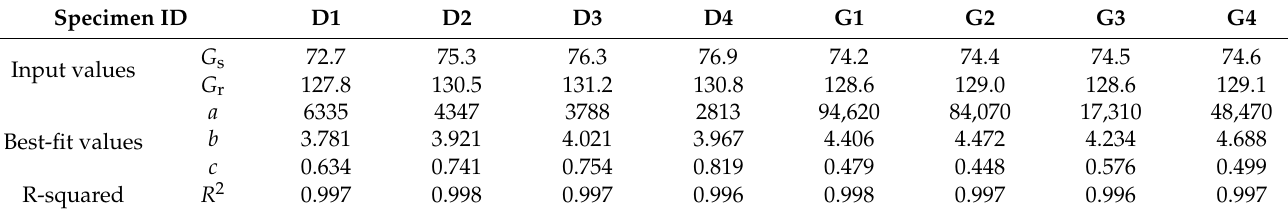
Table 3. The result of model fitting and